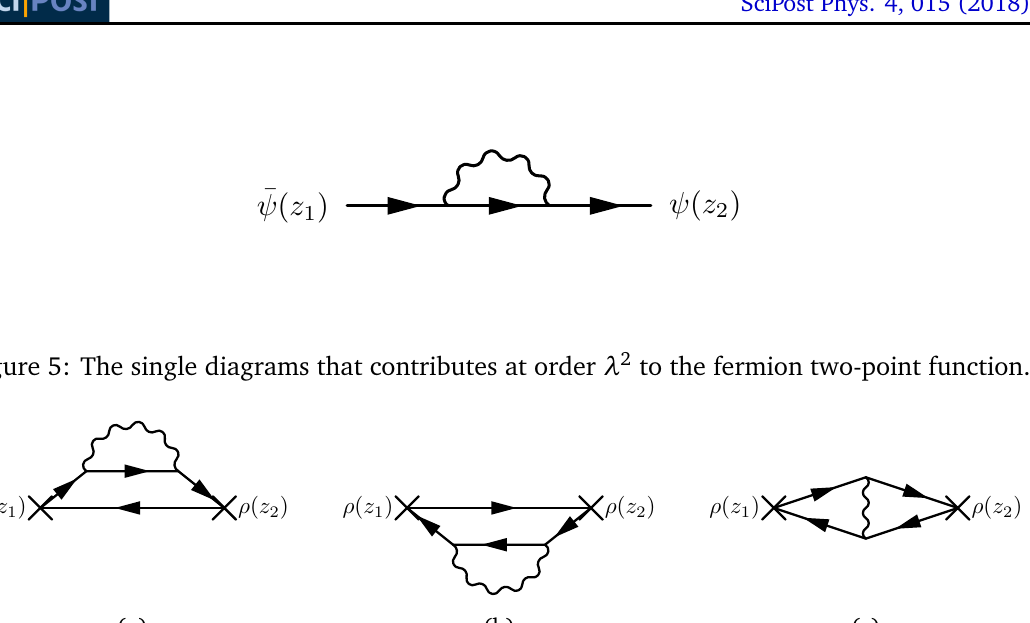
Figure 6: The three diagrams that contribute at order λ 2 to the density-density correlation